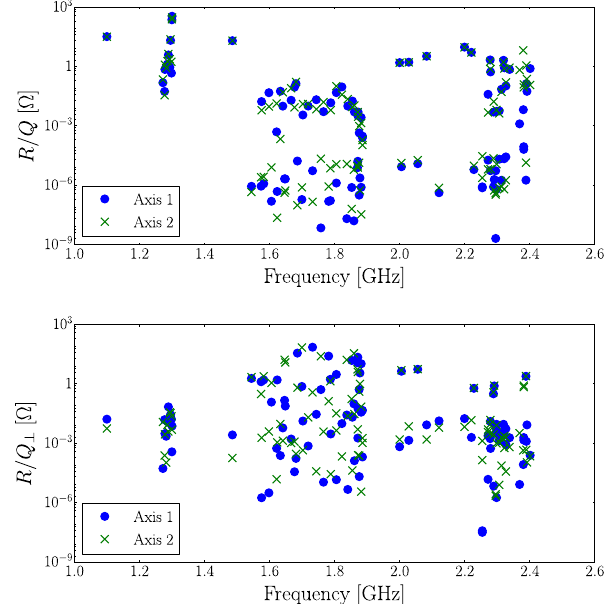
FIG. 9. The longitudinal and transverse R=Q evaluated along both axes.